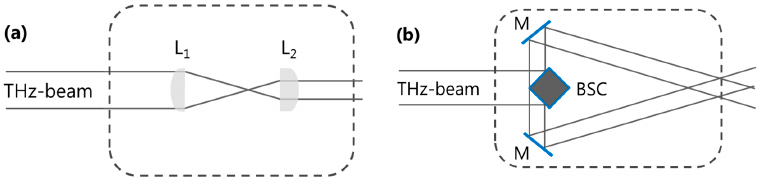
Figure 2. Experiment area, schematic. ( a ) beam collimation with lenses L 1 and L 2 ; ( b ) two ‐ beam interference, based on a surface reflecting beam splitter cube (BSC) and two mirrors (M).